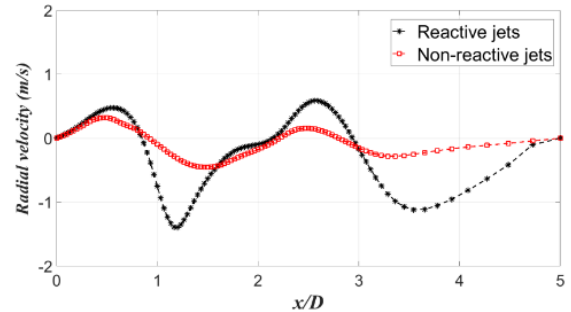
Figure 15. Radial velocity distributions with and without combustion effects (z/D = 5).